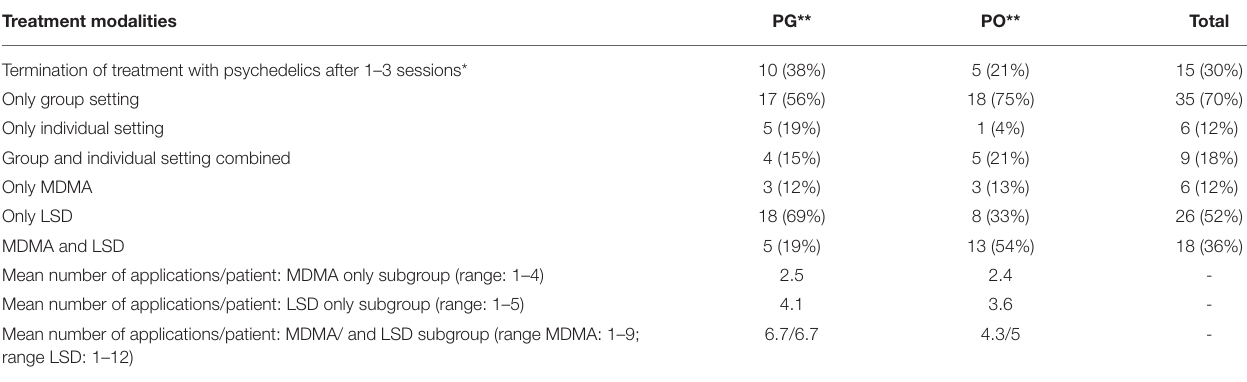
TABLE 2 | Treatment modalities. Treatment modalities